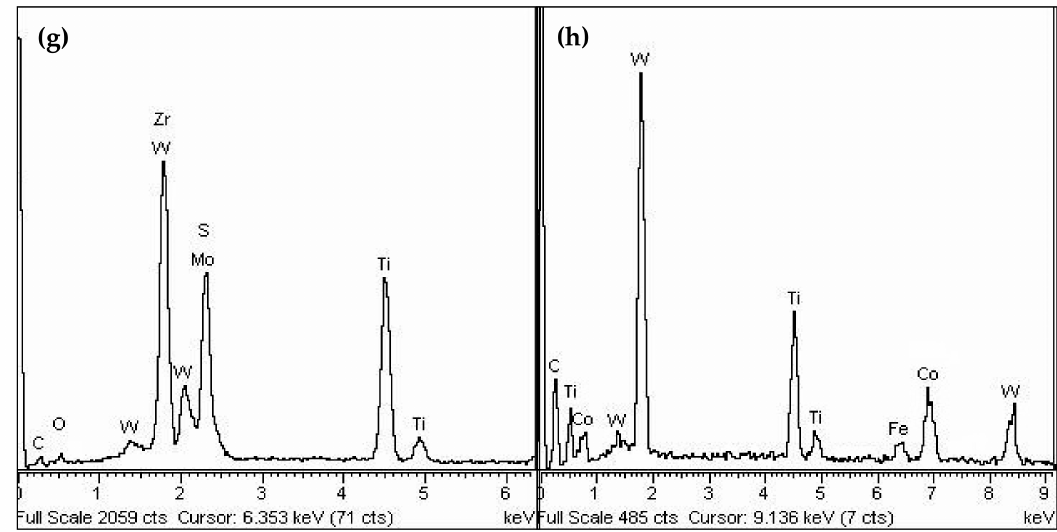
Figure 12. The corresponding composition analysis ( a – h ) of points (A)–(H) in Figure